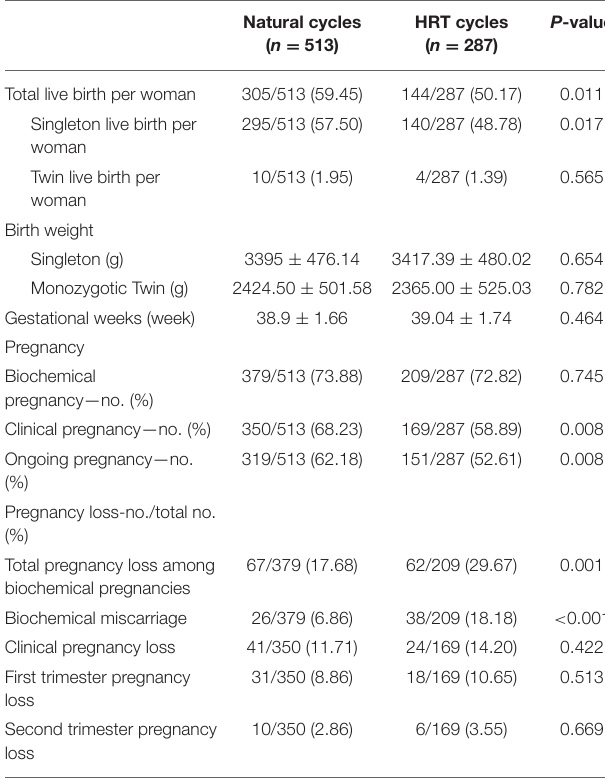
TABLE 1 | Baseline characteristics. TABLE 2 | Livebirth, birthweight, pregnancy, and pregnancy